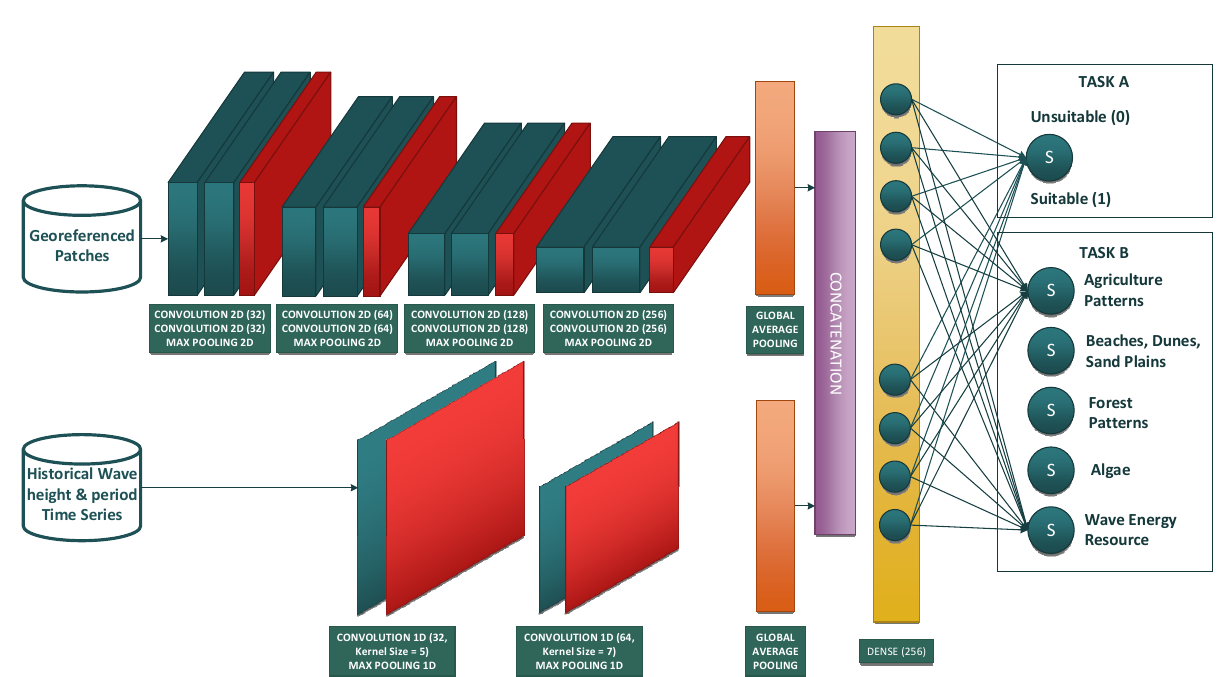
Figure 5. Multitask Data Fusion based Neural Network Architecture.